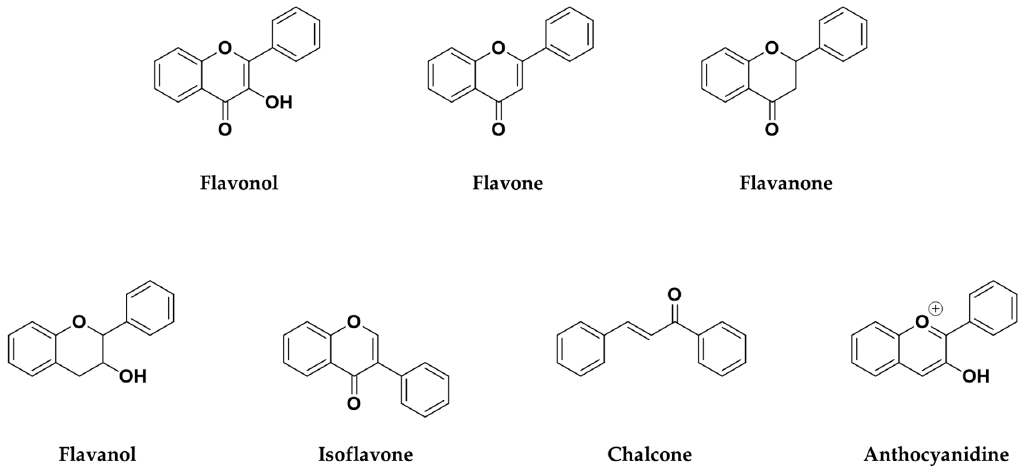
Figure 4. Chemical structure of the major subclasses of flavonoids.